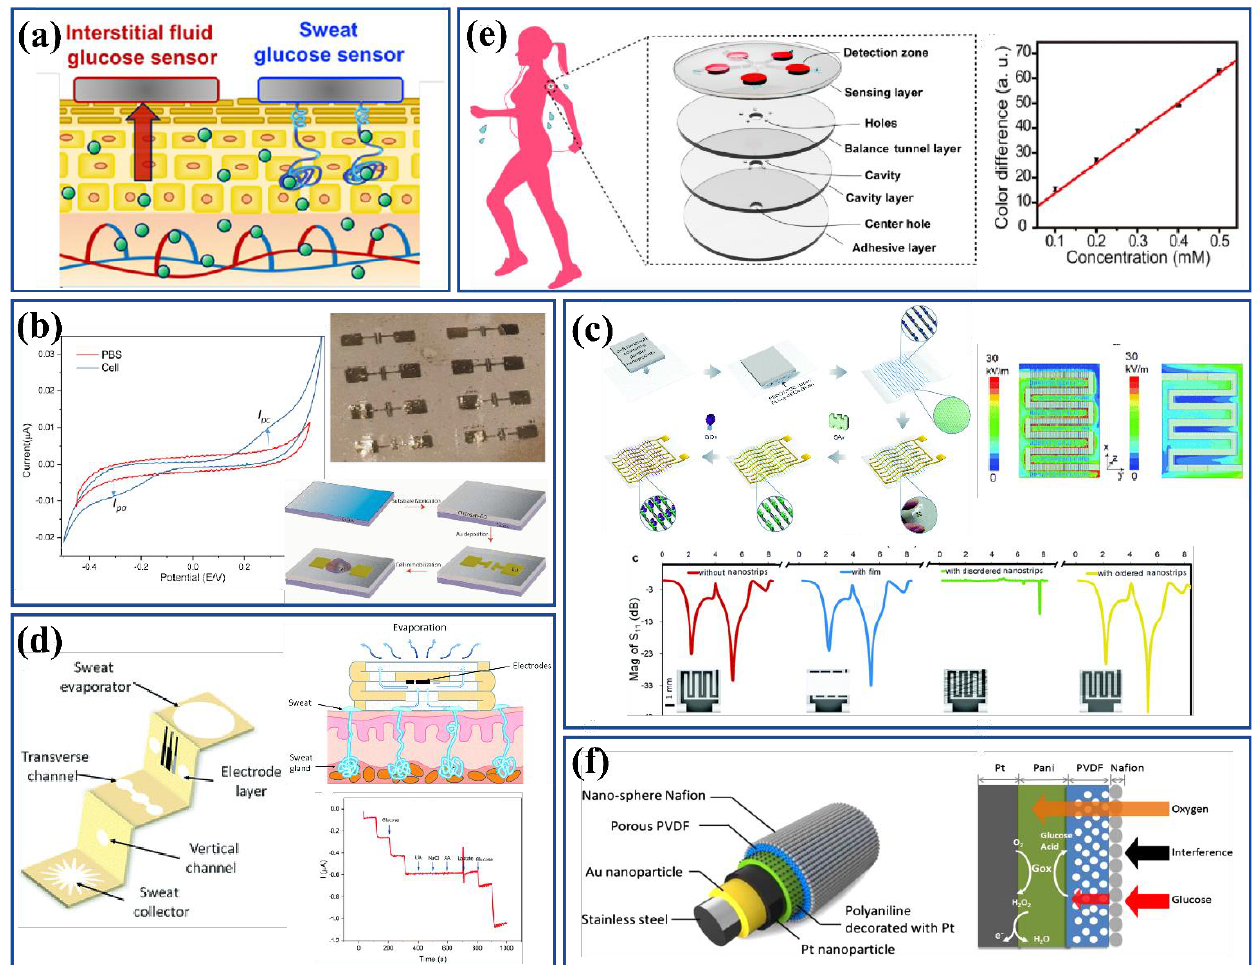
Figure 7. ( a ) Schematic representation of glucose monitoring sample generation. (Reproduced with permission from Kim et al., Talanta, vol. 177, pp. 163–170, 2018 [101]. Copyright 2018, Elsevier Ltd.) ( b ) Illustration of chitosan-GO substrate fabrication. (Reproduced with permission from Janyasupab et al., 2018 IEEE-EMBS Conf. Biomed. Eng. Sci. IECBES, pp. 577–582, 2018 [110]. Copyright 2018, IEEE.) ( c ) Representation of nanostrip biosensor fabrication and enzyme immobilization. (Reproduced with permission from Xui et al., Nanoscale Horiz., 2020 [96]. Copyright 2020, Royal Society of Chemistry.) ( d ) Graphics of the 3D-PMED sensor applied on human skin . (Reproduced with permission from Cao et al., R. Soc. Chem., vol. 9, pp. 5674 – 5681, 2019 [114]. Copyright 2019, Royal Society of Chemistry.) ( e ) Layers and zones of the glucose sensor. (Reproduced with permission from Xiao et al., Anal. Chem., 2019 [36]. Copyright 2019, American Chemical Society.) ( f ) Illustration of nanostructure layers and working principle of the sensor. (Reproduced with permission from Chen et al., Biosens. Bioelectron., vol. 74, pp. 1047 – 1052, 2015 [121]. Copyright 2015, Elsevier Ltd.)